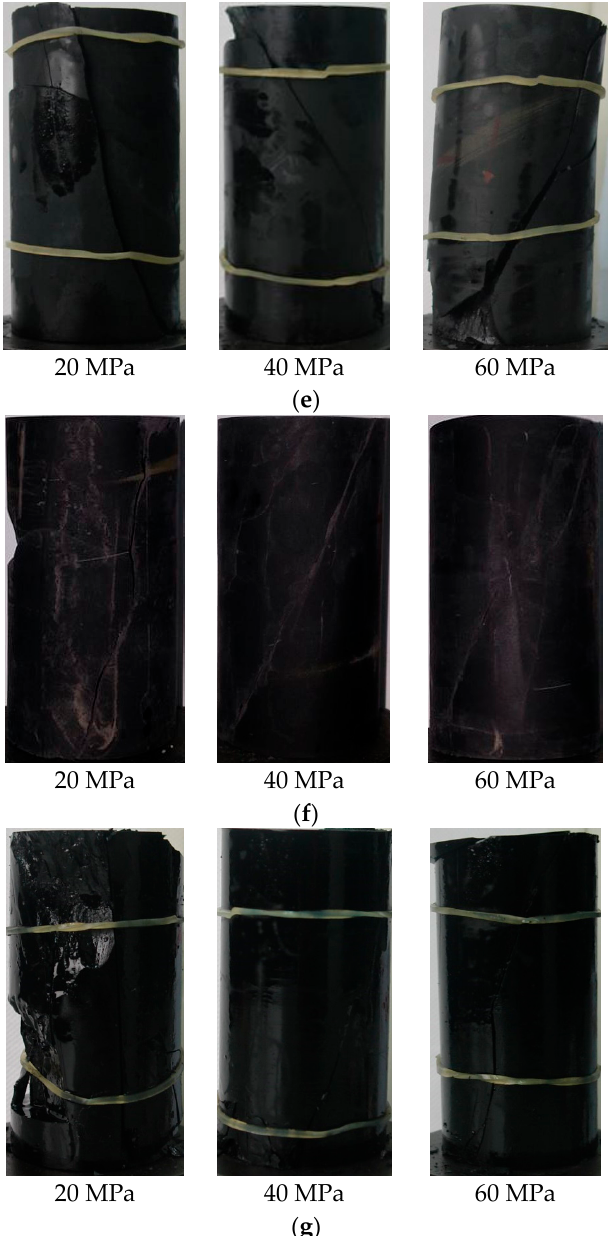
Figure 10. Failure morphology of samples with inclination angles ( β ) of: ( a ) 0°; ( b ) 15°; ( c ) 30°; ( d ) 45°; ( e ) 60°; ( f ) 75°; and ( g ) 90° of shale samples subjected to different confining pressures in triaxial compression.